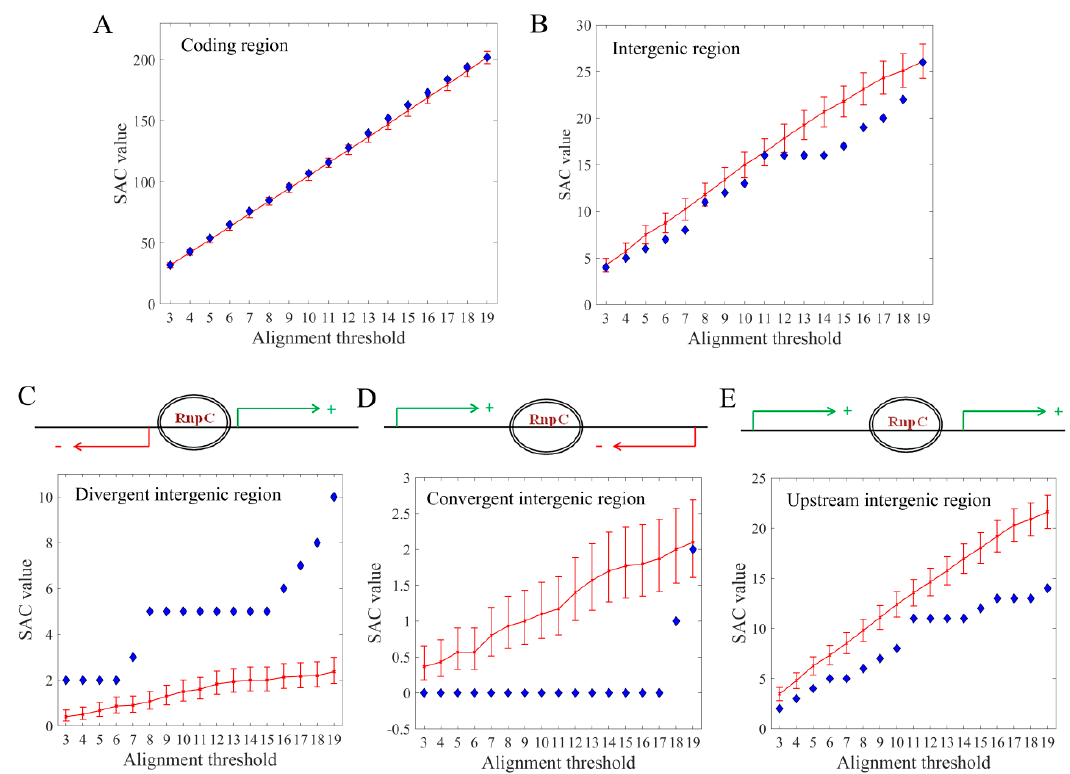
Figure 4. ( A ) SAC values associated with hits located in coding and ( B ) intergenic regions of E. coli